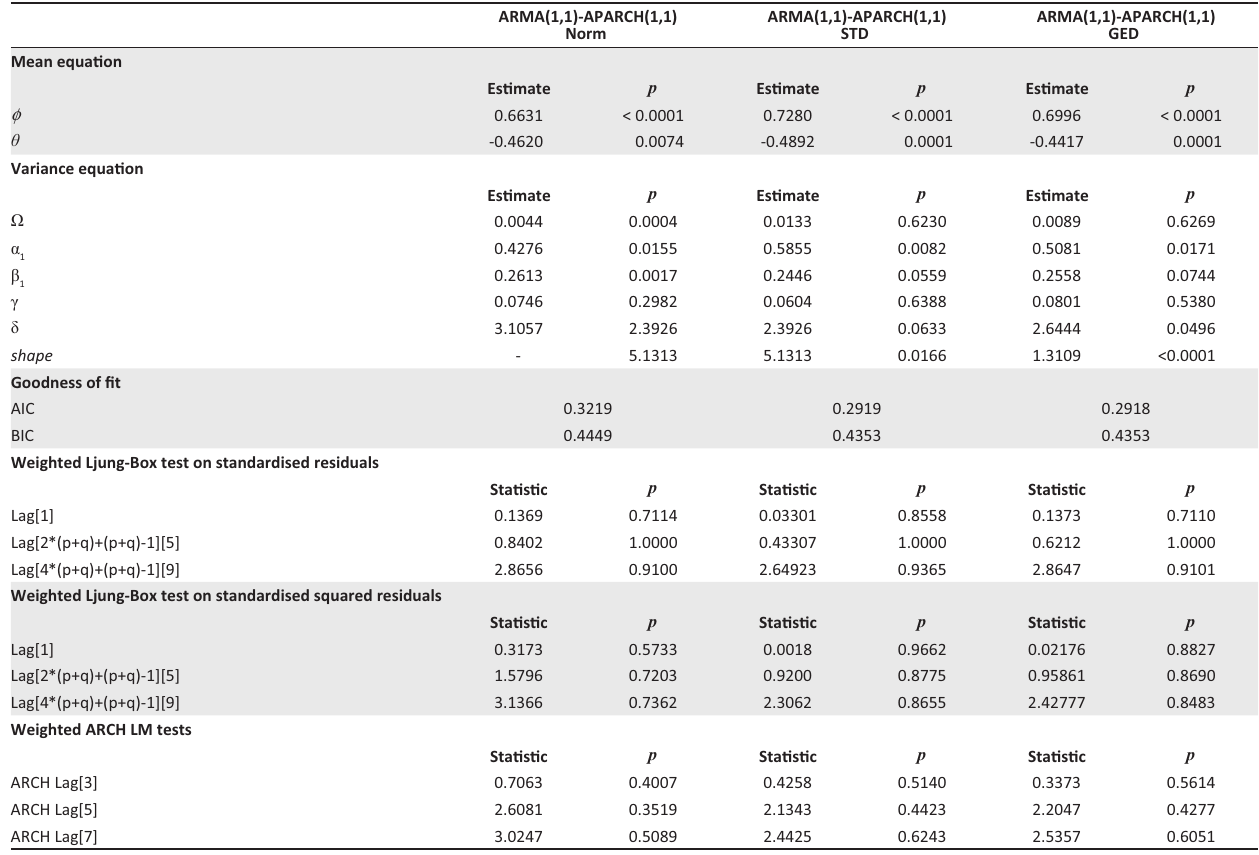
FIGURE 6: ARMA(1,1)-APARCH(1,1)